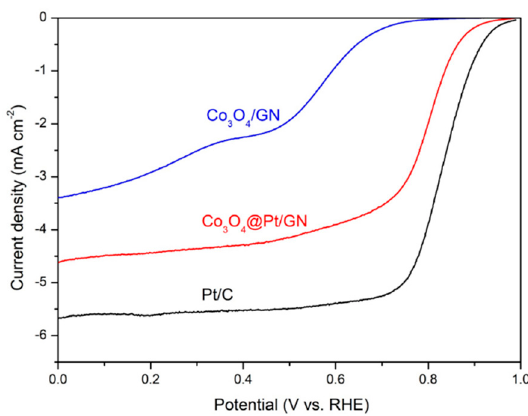
Figure7. Theoxygenreductionreaction(ORR)activitiesinapparentcurrentdensityforCo 3 O 4 / graphene Figure 7. The oxygen reduction reaction (ORR) activities in apparent current density for (GN), Co 3 O 4 @Pt / GN, and Pt / C. The experiments were conducted in an oxygen-saturated 0.1 M KOH Co 3 O 4 /graphene (GN), Co 3 O 4 @Pt/GN, and Pt/C. The experiments were conducted in an oxygen- aqueous solution at 1600 rpm and a scan rate of 5 mV s − 1 saturated 0.1 M KOH aqueous solution at 1600 rpm and a scan rate of 5 mV s − 1 .